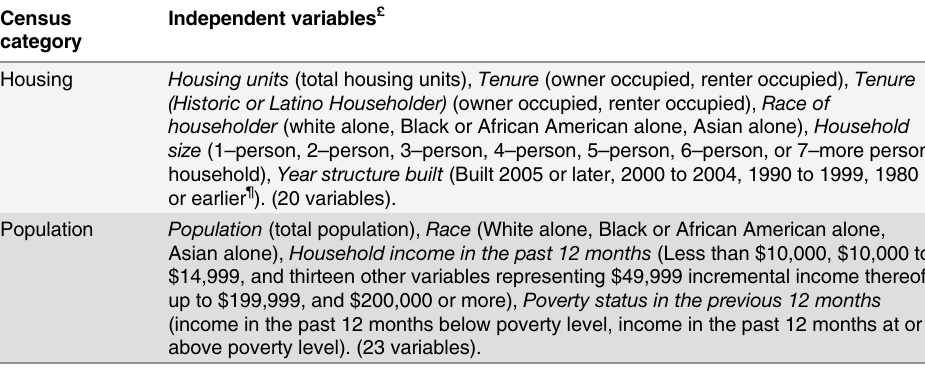
Table 3. Population and housing variables evaluated in the